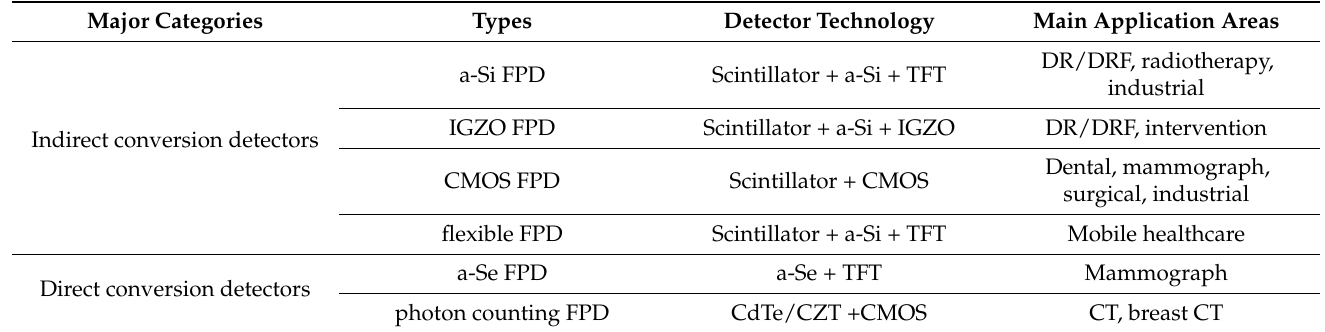
Table 1. The technologies used by different types of detectors and their main application